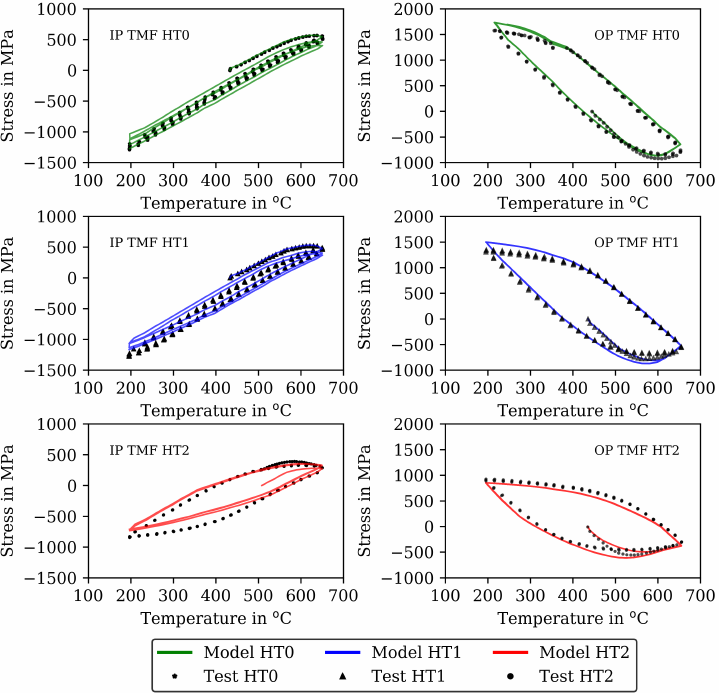
Figure 12. Measured stress and stress calculated with the model of step 1 for the first three cycles of the TMF tests for the HT0, HT1, and HT2 material: In-phase TMF stress–temperature hysteresis loops (mechanical strain amplitude of 0.005, left ) and out-of-phase TMF stress–temperature hysteresis loops (mechanical strain amplitude of 0.01, right